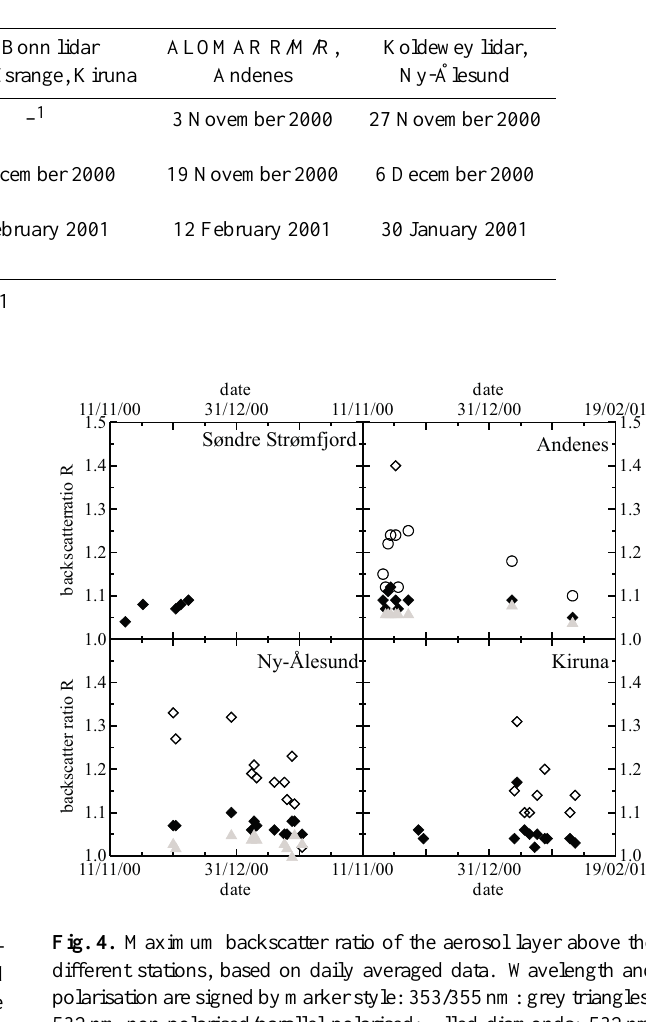
Table 2. Period of observation of the aerosol layer at different stations